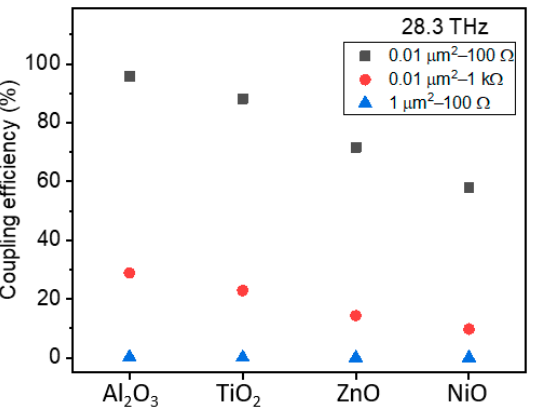
Figure 7. Calculated coupling efficiency for the MIM rectenna device at 28.3 THz using 3 nm oxide thickness and dynamic permittivity values as stated in Table 4.